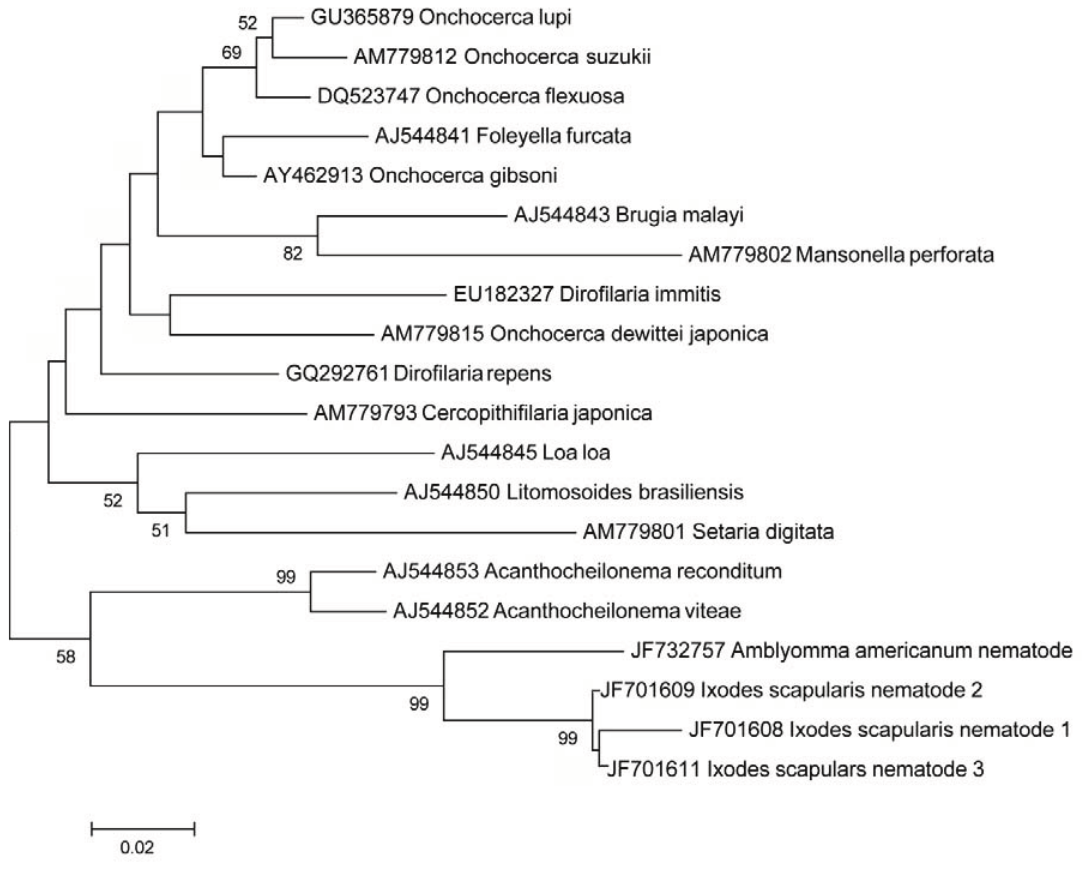
Figure 3. A neighbor-joining phylogenetic analysis of a 200 bp alignment of the mitochondrial 12S rDNA gene of the three microfilarial nematode isolates obtained from our study (JF70108-11) compared to other species in Onchocercidae family using MEGA 5 Evolutionary Genetics Analysis program. Alphanumeric codes represent